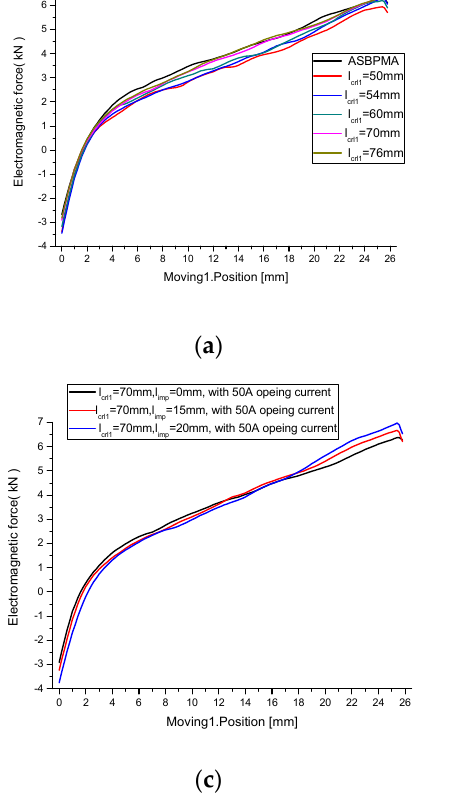
Figure 6. The characteristics curve of the presented ABSMPMA. ( a ) The characteristic of the elec- tromagnetic force vs. moving position with 50 A opening current. ( b ) The characteristic of the electromagnetic force vs. moving position with 50 A closing current for ABSMPMA with different initial mover position. ( c ) The characteristic of the electromagnetic force vs. moving position with 50 A opening current for ABSMPMA with different initial mover position.